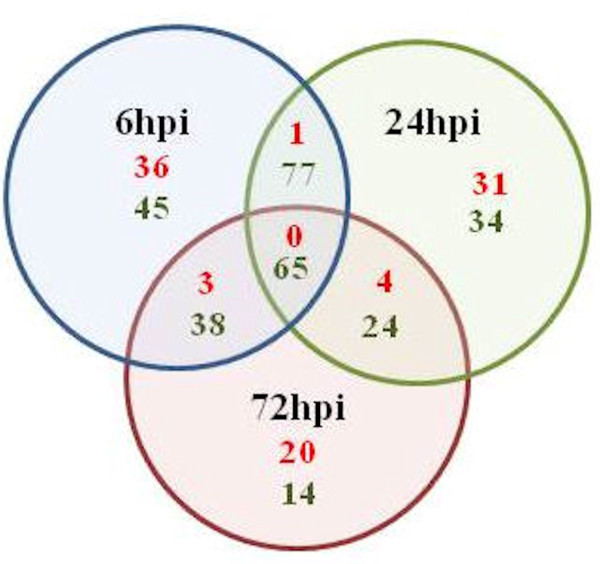
Venn diagram demonstrating the number of up-regulated genes (numbers in red) vs the down-regulated (numbers in green) subsequent to Xcc inoculation. Results were based on the mean inductions of six experimental replicates. Genes with M-values>0.5 (1.5 fold) were considered up-regulated while M-values<0 were considered down-regulated.